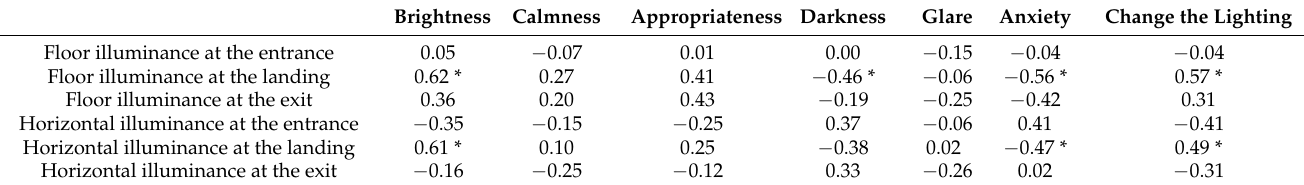
Table 6. Correlation between physical quantities and impression evaluation items (* p <